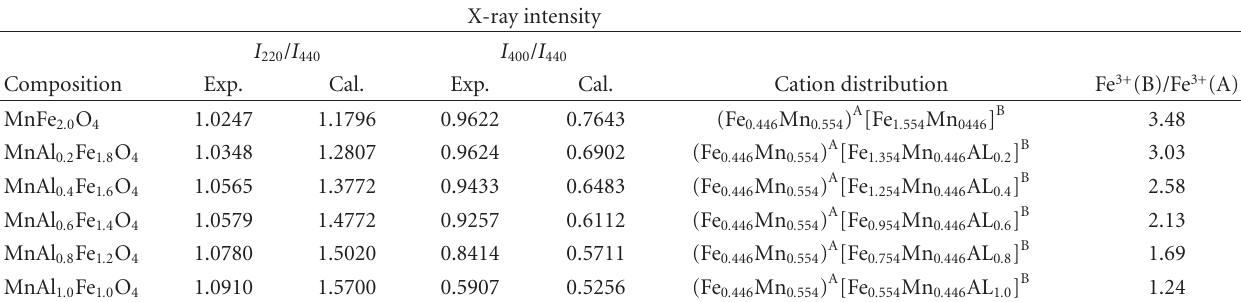
Table 2: Cation distribution data calculated from XRD pattern of the MnAl x Fe 2 . 0 − x O 4